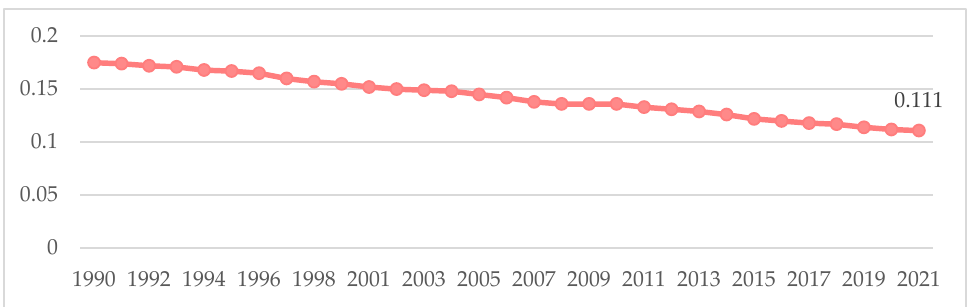
Figure 9. Energy intensity in the world, according to data for 1990–2021, koe/$15p [30].